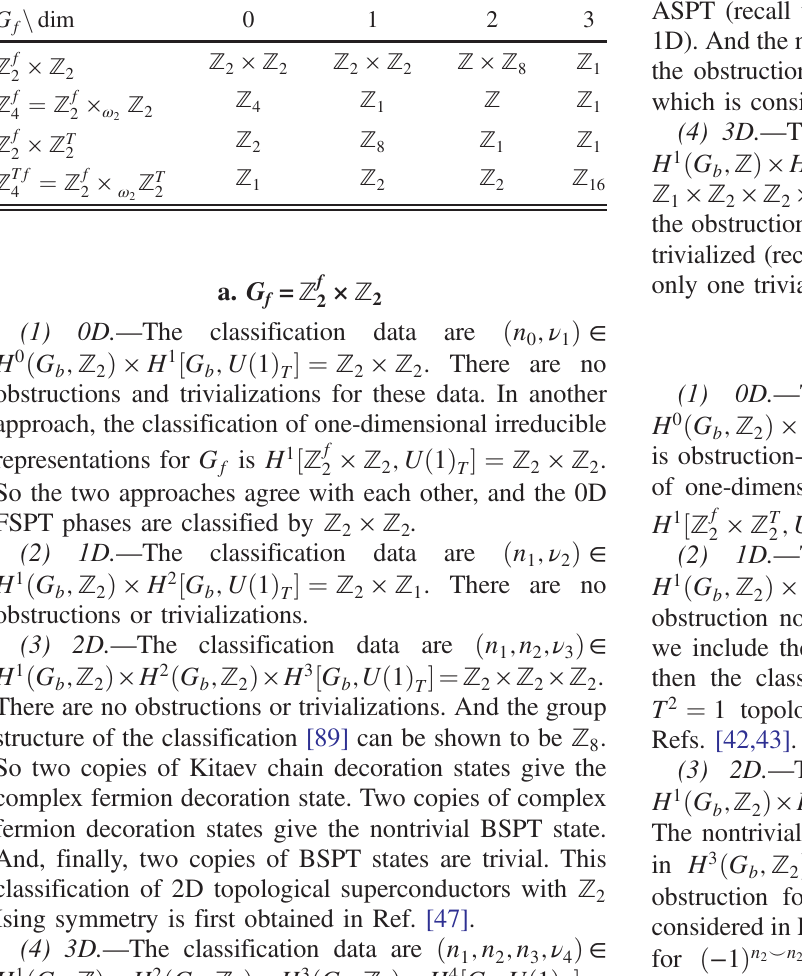
ω 2 . The differences